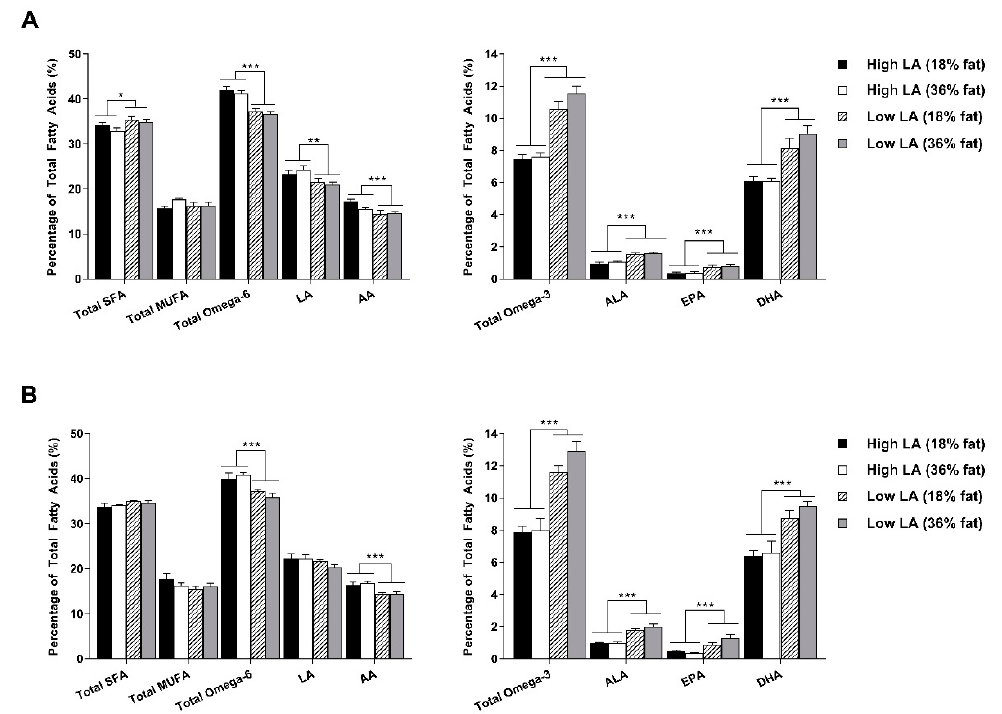
Figure 3. Liver fatty acid profile in ( A ) male and ( B ) female offspring at 4 weeks of age. Values are means ± SEM and n = 6–9 per group. The effects of maternal dietary fatty acid ratio and maternal dietary fat content were determined using a two-way ANOVA; all comparisons were made within sex group. * Indicates significant difference (* p < 0.05, ** p < 0.01, *** p < 0.001). SFA, saturated fatty acid; MUFA, monounsaturated fatty acid; LA, linoleic acid; AA, arachidonic acid; ALA, alpha-linolenic acid; EPA, eicosapentaenoic acid; DPA, docosapentaenoic acid; DHA, docosahexaenoic acid.